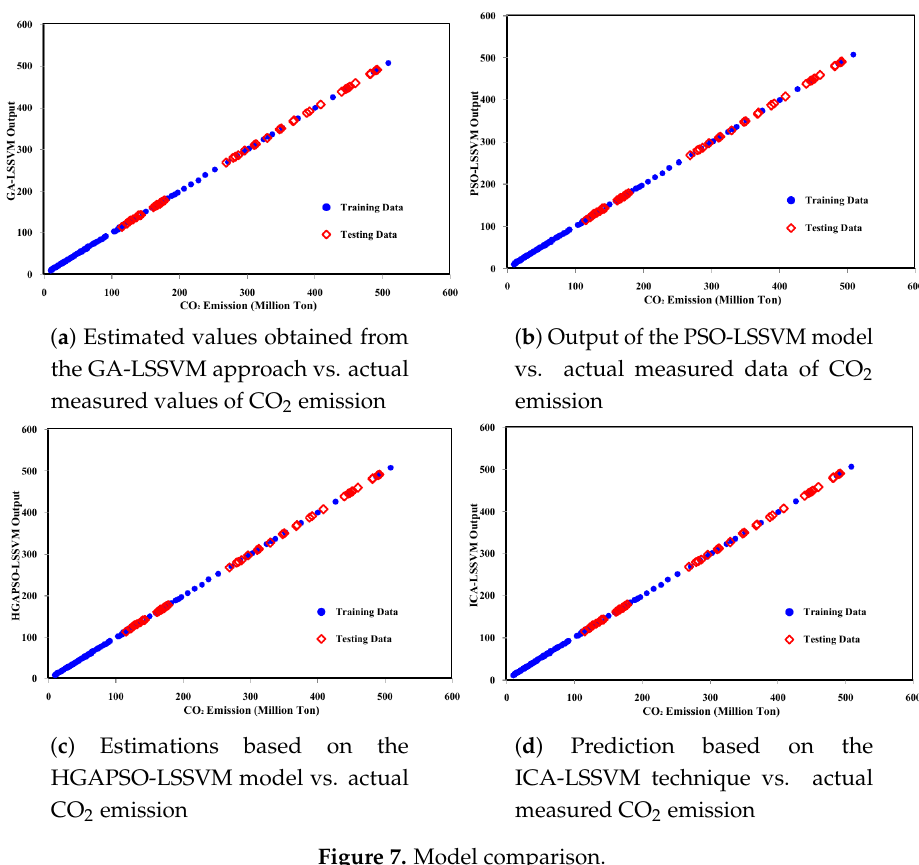
Figure 7. Model comparison.